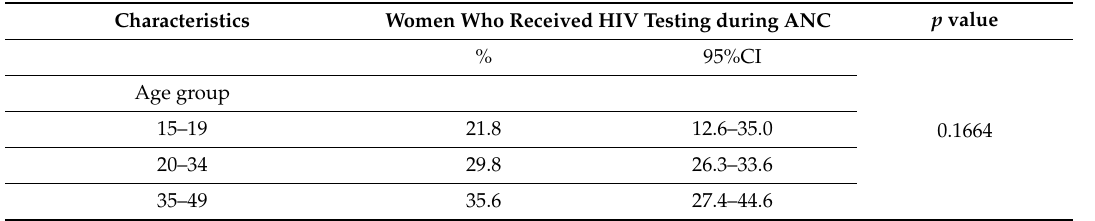
Table 2. Human immunodeficiency virus (HIV) testing during antenatal care among women aged 15–49 who had a live birth in the last two years by di ff erent socioeconomic variables, Vietnam, MICS 2014.